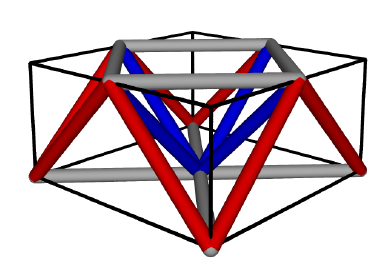
Figure 2. Half the conventional unit cell (thin black lines) of a face-centered cubic resistor lattice. The resistive rods represented in gray interconnect nodes located within the same horizontal plane. The blue rods are located inside the unit cell. The red rods, located in the vertical faces, are shared by two adjacent cubic